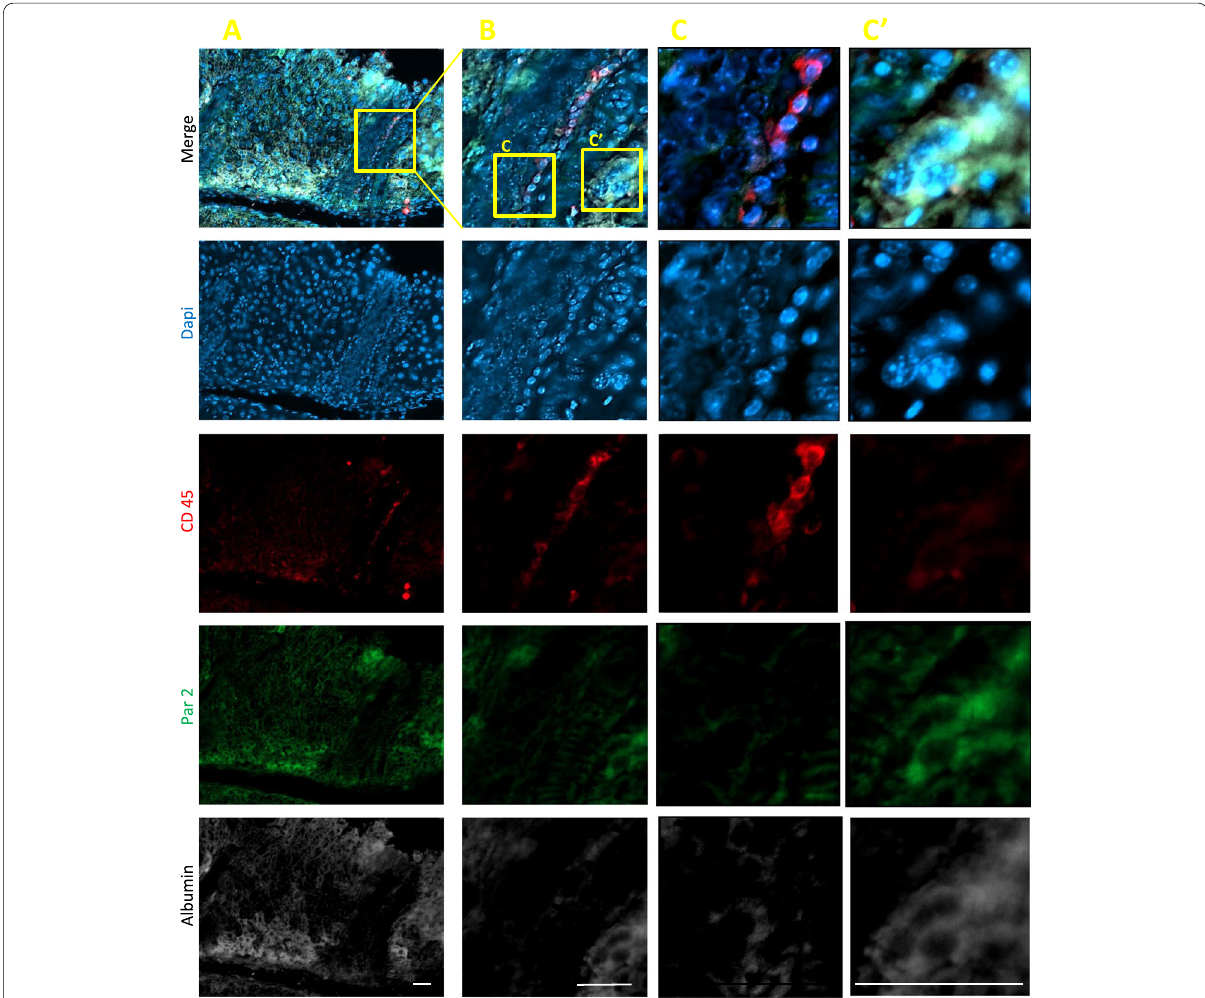
Fig. 2 Par2 expression is maintained in WT hepatocytes and not in WT leukocytes 14 days after ConA injection. The core of large infiltrates is composed of apoptotic cells, which are CD45, Par2, and albumin negative. The apoptosis is indicated by the loss of the normal nuclei structure (note the ring-like circle of the Dapi staining, most apparent in C . The outer layer of the mononuclear infiltrate is composed of CD45 (shown in red). At day 14, these cells do not express Par2 and present normal nucleus. Healthy hepatocytes are not present in the infiltrate and observed by the uneven albumin staining of the infiltrate. At this stage of the ConA model, all apparent Par2 observed in A and C ’). The albumin staining is an indication of a functional hepatocyte. A Low, B middle, and C high magnifications. Scale bar +